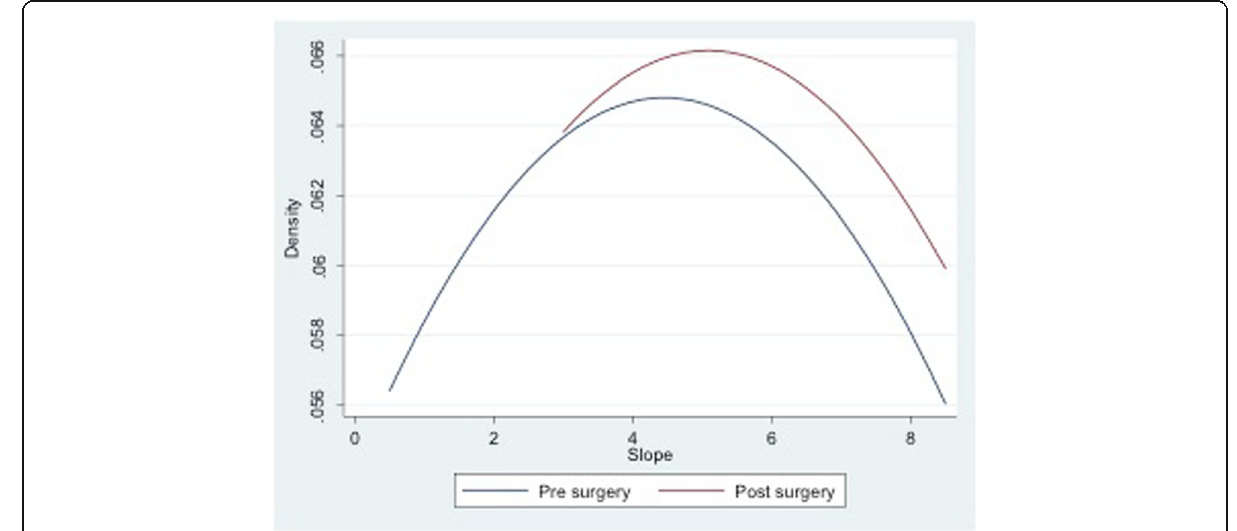
Fig. 6 Pre- and postoperative tibial slopes